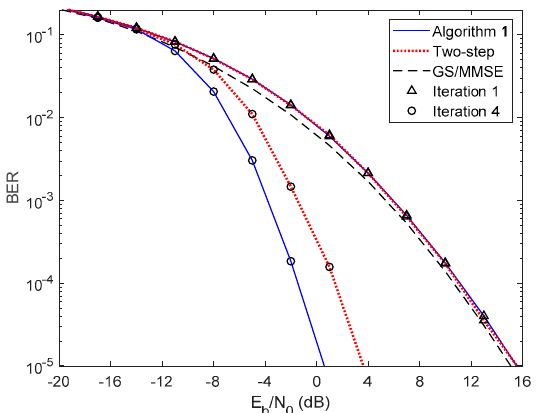
Figure 7. Performance of the proposed hybrid iterative multi-user equalizer (Algorithm 1) for the PCSI precoder with ULA configuration and 16 QAM modulation.